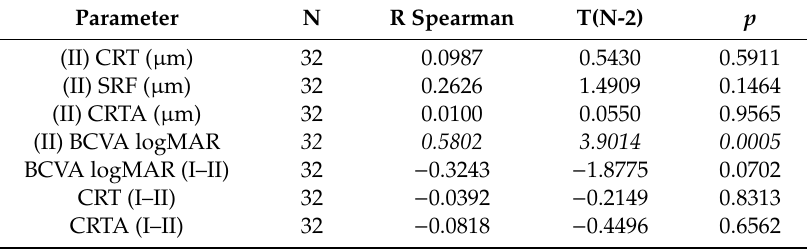
Table 3. Spearman correlation rank test for the relationship between the duration of CSCR and the parameters of retinal morphology and function after treatment.